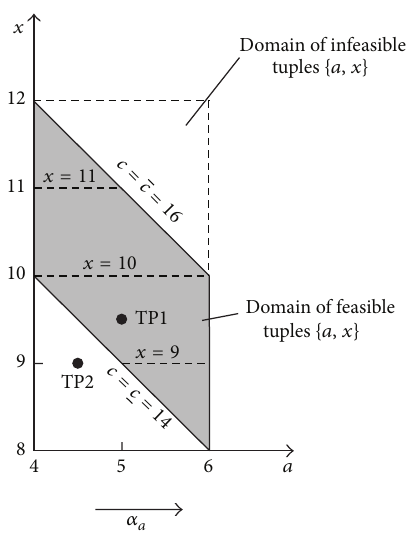
Figure 20: Support of the 3D membership function of the solution from Figure 19. TP1 = (5, 9.5) and TP2 = (4.5,9) are examples of test points that can be used for the correctness testing of obtained